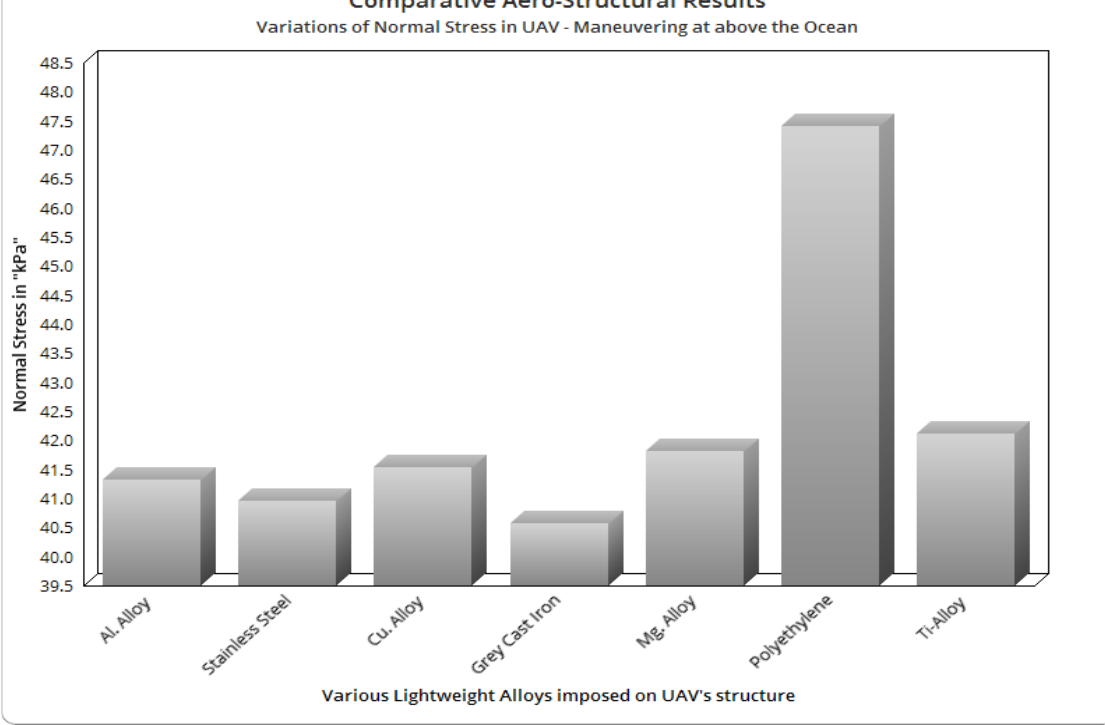
Figure 20. Comparative Normal stress variations for various alloys.